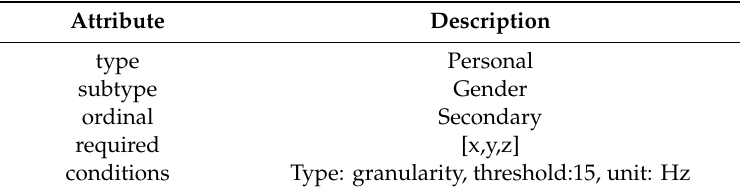
Table 4. Accelerometer personal data schema.